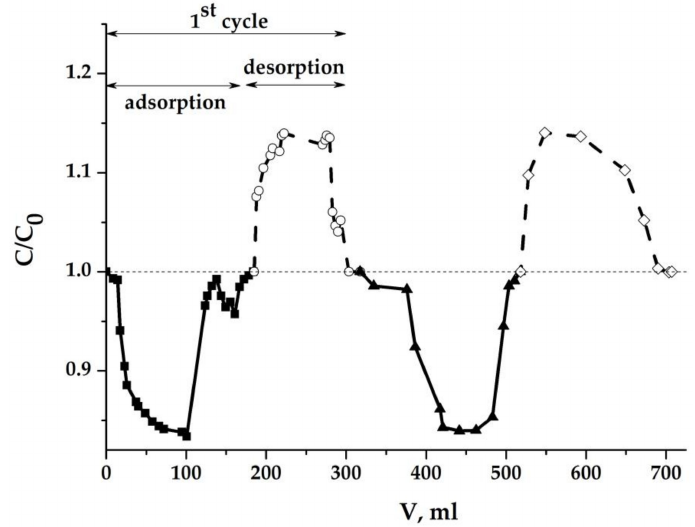
Figure 13. NaCl concentration in the e ffl uent in dynamic process: C 0 = 1 g / dm 3 (0.717 eqv / dm 3 ); U = 1.2 V; electrodes (cm): 3 × 3 × 0.5; flow rate: 0.69 cm 3 / min; electrode gap: 0.2